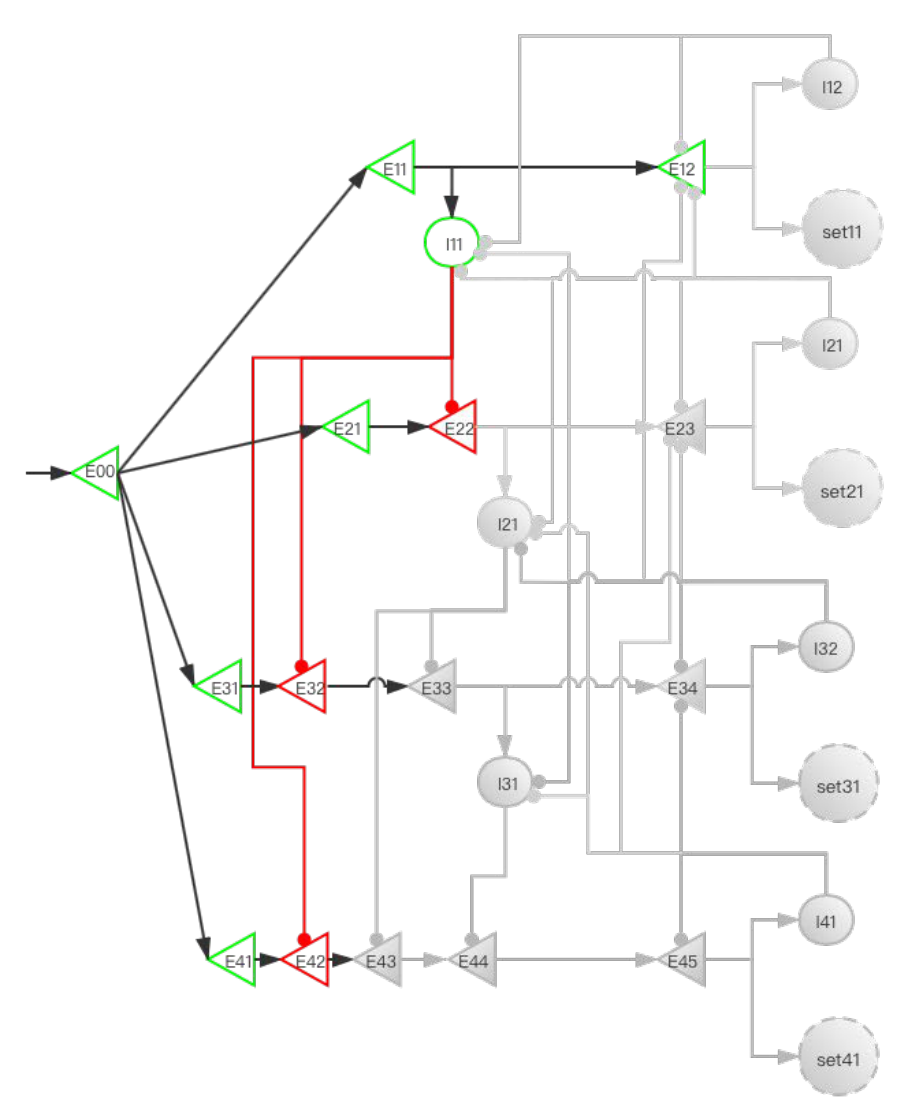
Figure 7. The activity of neurons in the time period from the first signal entering E00 to the activation of E12 (before set11 is activated). After the signal reaches E11, I11 is activated. At this time, E22 also has a signal. However, the inhibitory signal intensity from I11 is greater than the excitatory signal intensity, so E22 is inhibited. Similarly, E32 and E42 are also inhibited; this ensures that the “winner takes